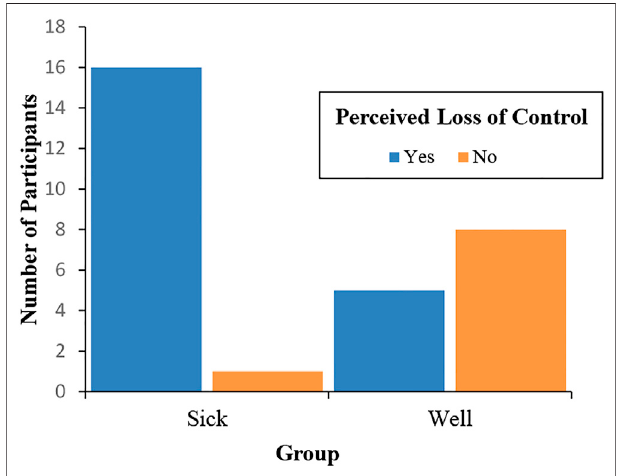
FIGURE 3 | Numbers of “ sick ” and “ well ” participants who did (and did not) experience a perceived loss of control during HMD VR.